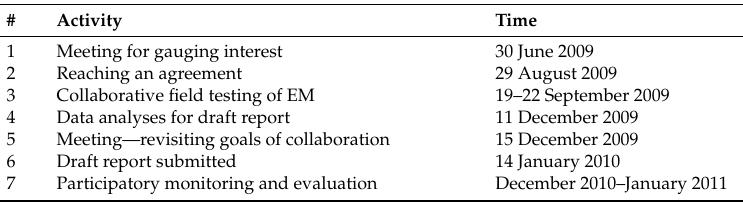
Table 2. Steps taken during 2009–2010 with Stakeholder